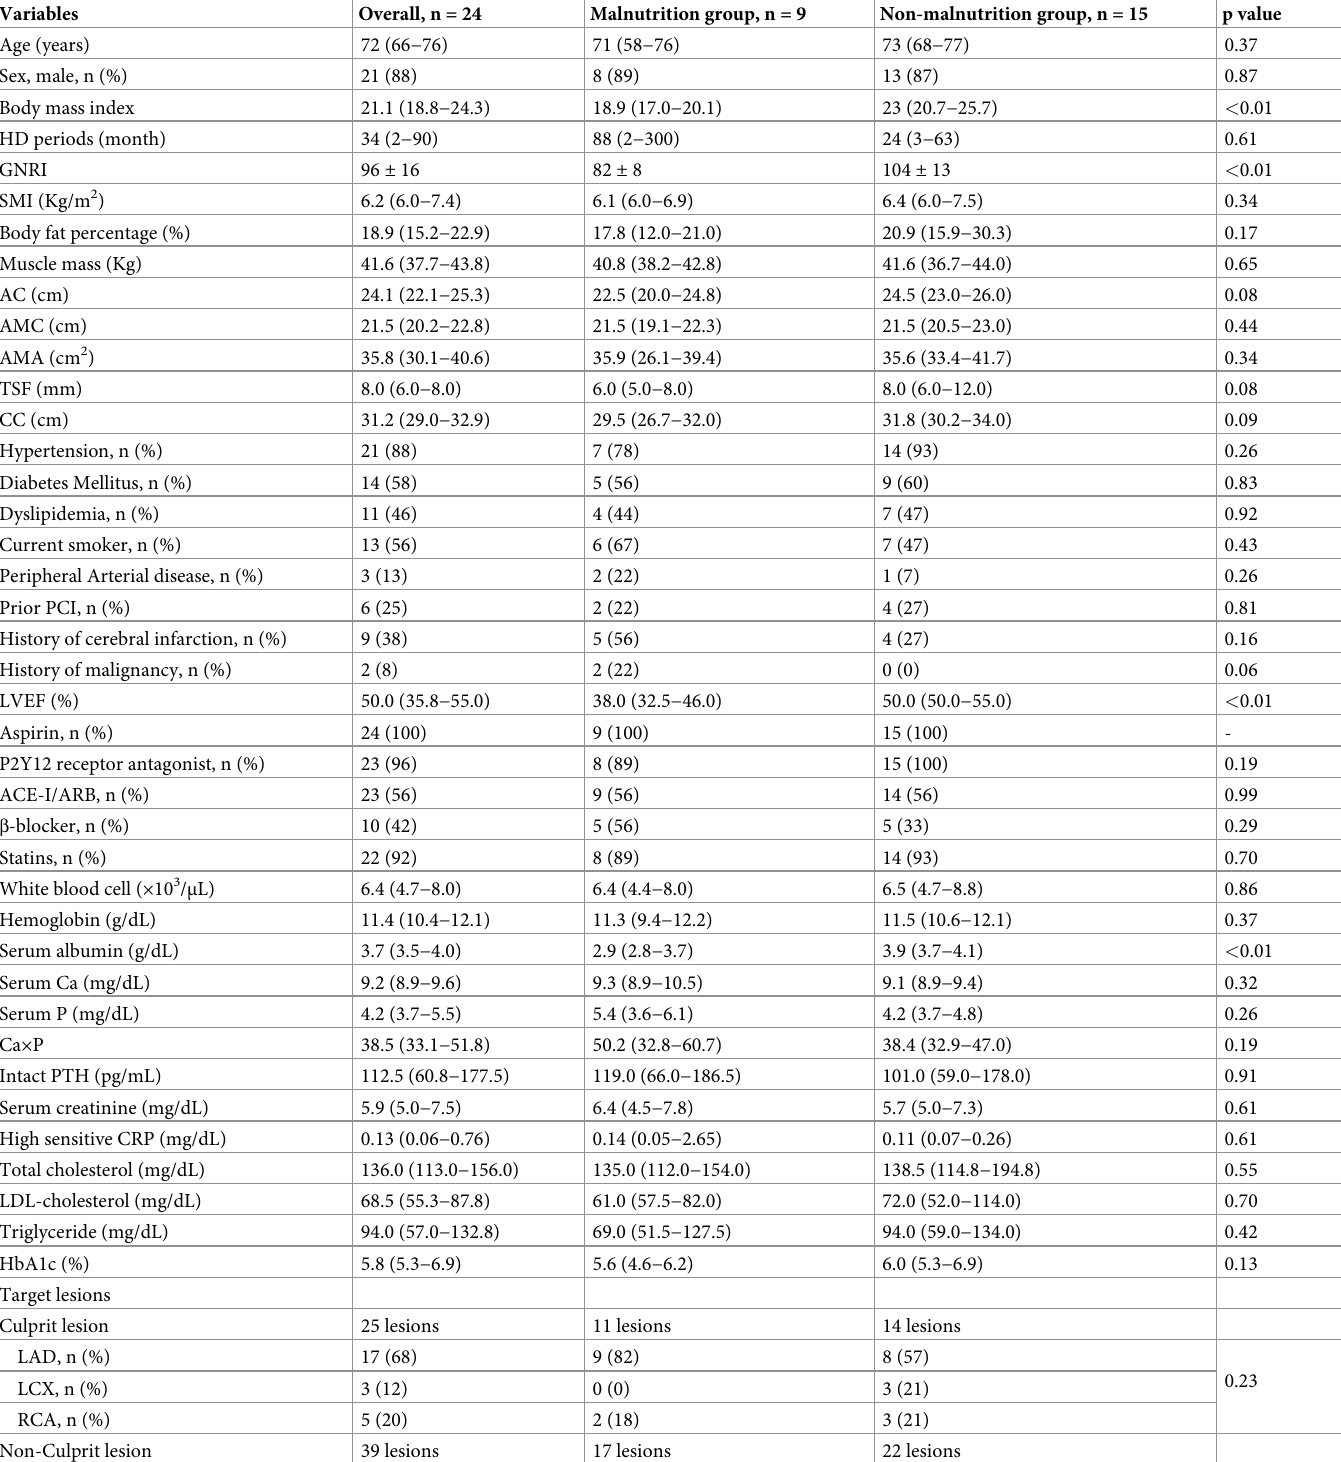
Table 3. Baseline clinical characteristics of patients who were followed up for 6